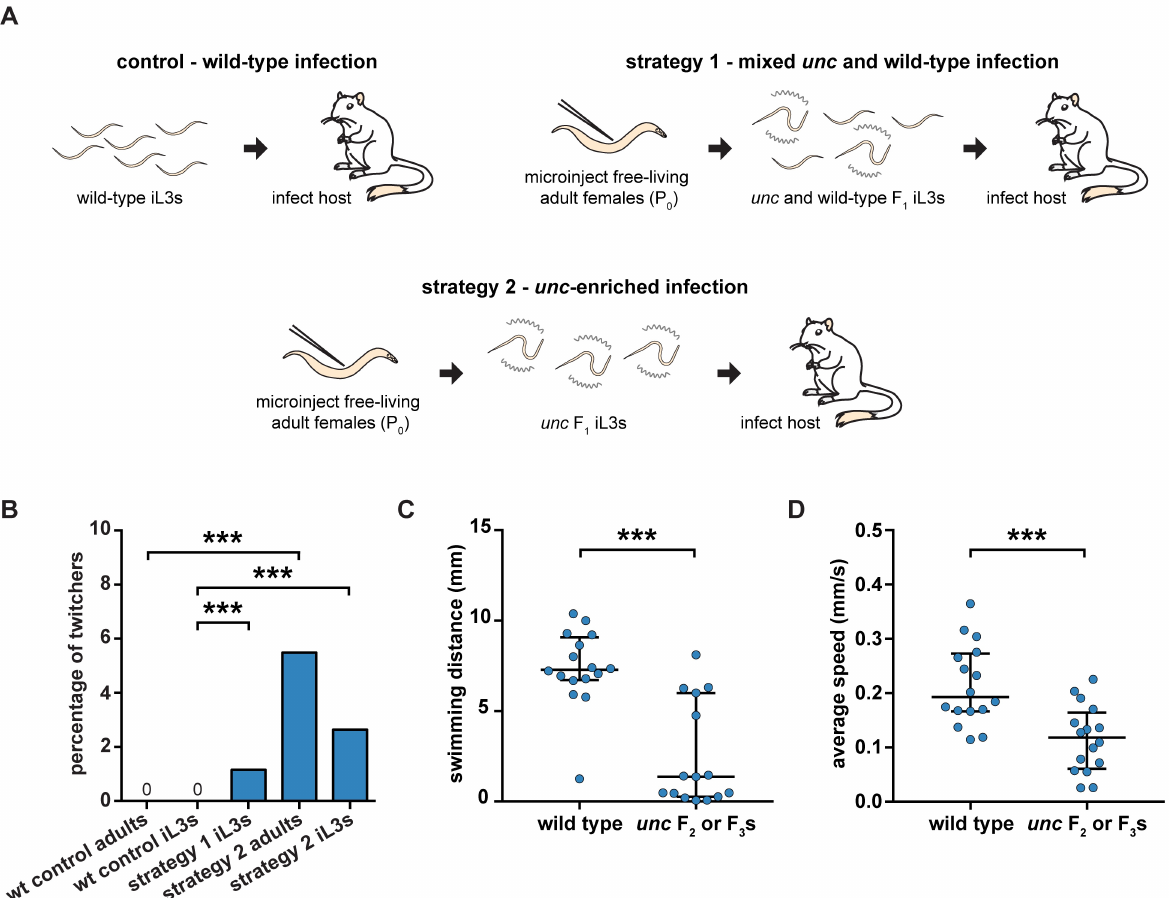
Fig 6. The unc phenotype is heritable following host passage. ( A ) Strategies for heritabletransmission of Ss-unc-22 mutations. Gerbil hosts were infected with either all wild-typeiL3s, a 50/50 mix of unc and wild-typeF 1 iL3s, or unc -enrichedF 1 iL3s. F 2 and F 3 progenywere collected from host feces and screenedfor unc phenotypes. Note that iL3s collectedfrom host feces can be the F 2 or F 3 generationdependingon whetherthey developed into iL3s directly, or after a free-livinggeneration (Fig 1A) [10]. ( B ) Twitching frequency of wild-typecontrol progenyand F 2 or F 3 progeny collectedfrom unc infections. The twitching frequency of the F 2 or F 3 iL3s collected from the mixed unc infection differed from that of wild-typeiL3s. *** P < 0.001, chi-squaretest with Bonferroni correction. n = 1,908–3,849 iL3s per condition. The twitching frequency of F 2 adults collectedfrom the unc -enrichedinfectiondiffered from that of wild-typeadults. *** P < 0.001, chi-squaretest with Bonferroni correction. n = 164–332adults per condition.The twitching frequencyof F 2 or F 3 iL3s collectedfrom the unc -enriched infection differed from that of wild-typeiL3s. *** P < 0.001, chi-square test with Bonferroni correction. n = 2,694–3,849 iL3s per condition. ( C ) Swimming distance for wild-typeiL3s vs. unc F 2 or F 3 iL3s over a 10-s period. unc iL3s swam shorter distances than wild-type iL3s. *** P < 0.001, Mann-Whitney test. n = 15–16 worms for each population.( D ) Mean crawlingspeed for wild-typeiL3s vs. unc F 2 or F 3 iL3s over a 20-s period. unc iL3s showedreducedcrawlingspeeds relative to wild-typeiL3s. *** P < 0.001, unpairedt test with Welch’s correction. n = 16 worms for each population.